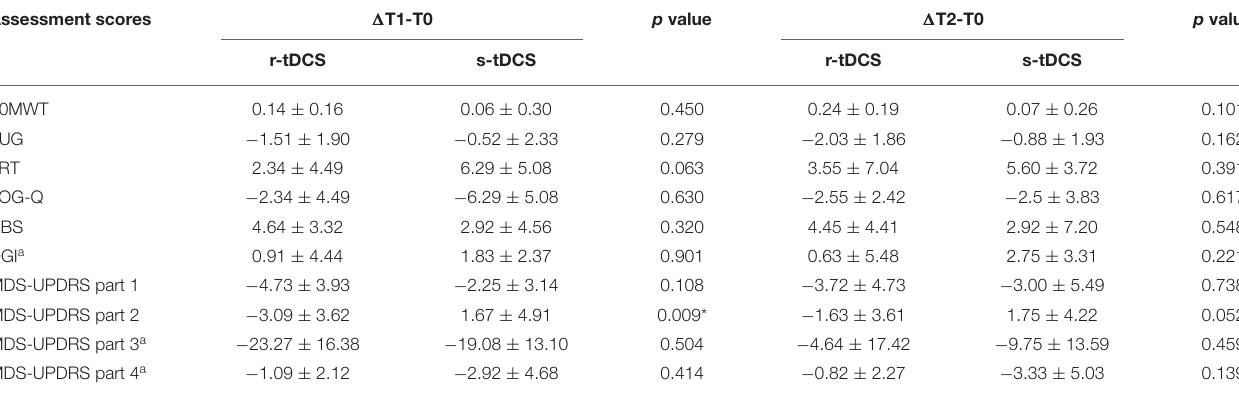
TABLE 2 | Differences between gait and balance measures at various time points between groups undergoing r-tDCS or s-tDCS interventions. Assessment